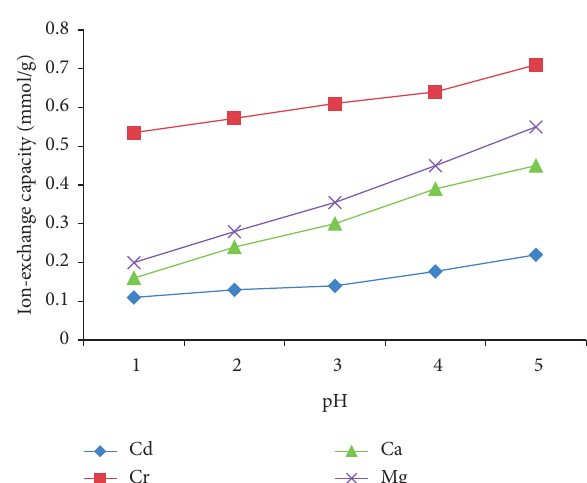
Figure 9: The metal uptake capacity of the ACF resin as a function of